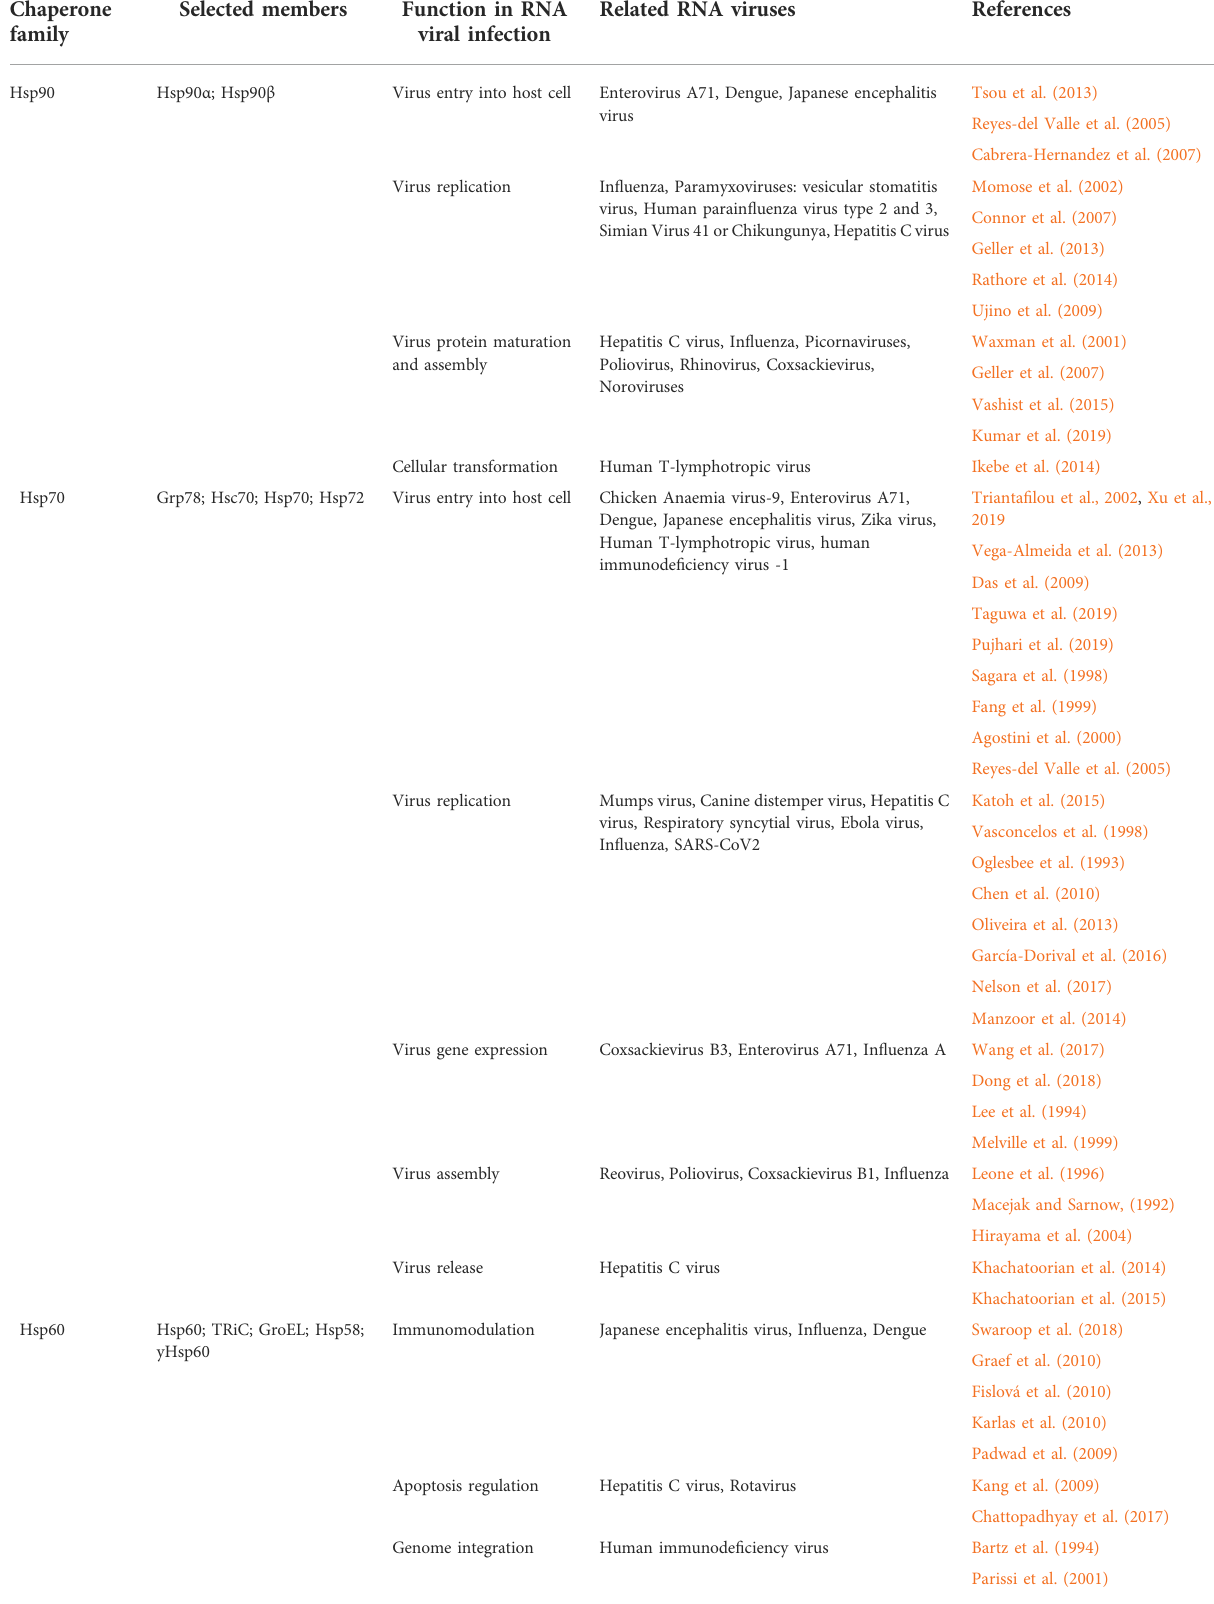
TABLE 2 The functions of Hsps in RNA virus